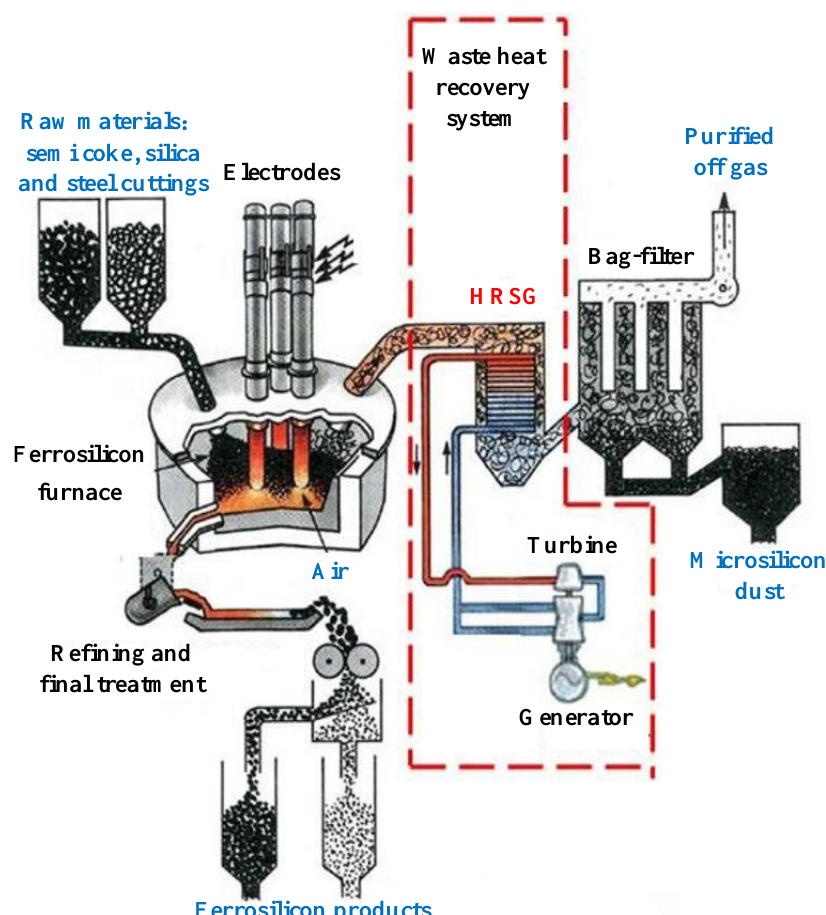
Figure 1. Diagram of the waste heat recovery